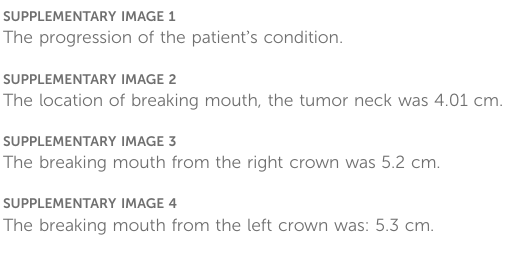
SUPPLEMENTARY IMAGE 1 The progression of the patient ’ s condition. SUPPLEMENTARY IMAGE 2 The location of breaking mouth, the tumor neck was 4.01 cm. SUPPLEMENTARY IMAGE 3 The breaking mouth from the right crown was 5.2